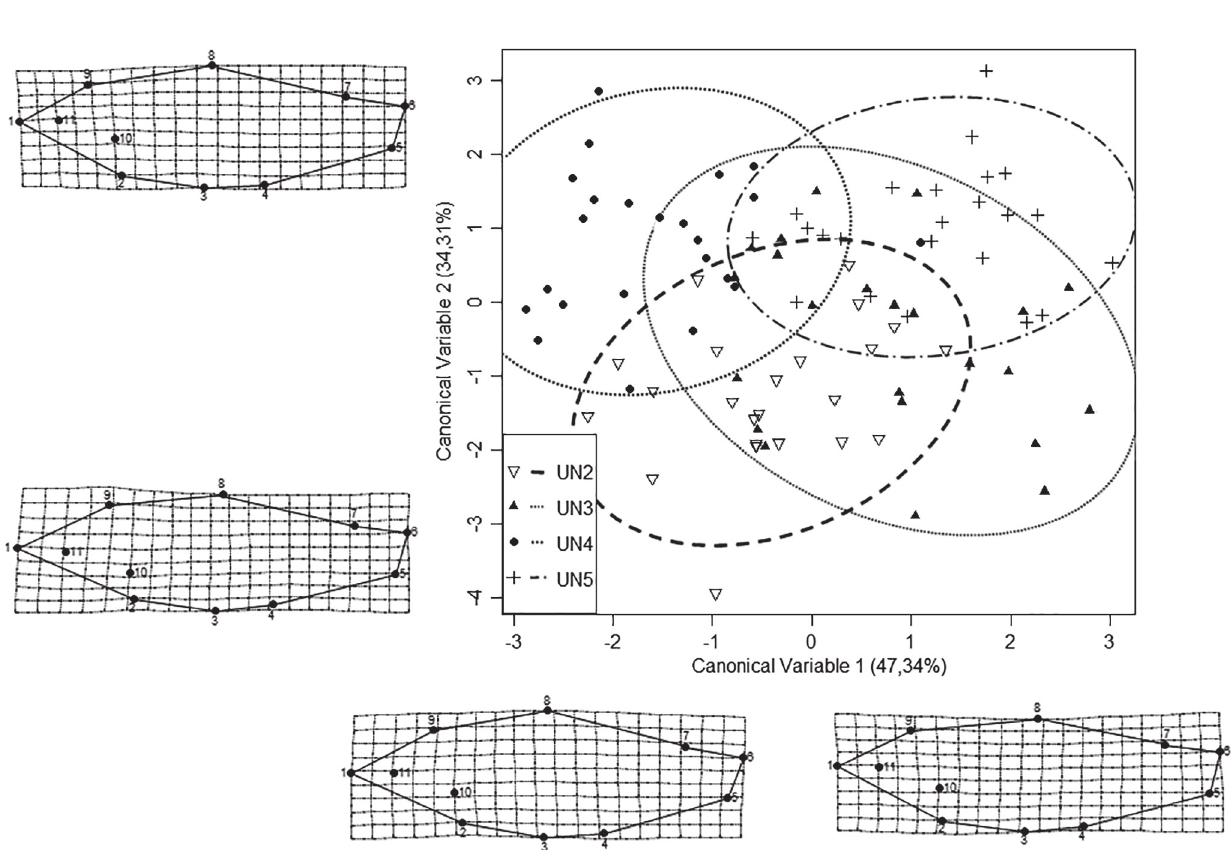
Fig. 5. Axes of morphological variation for population data set. Ellipses indicate the 95% confidence interval for each population. Deformation grids represent positive and negative extremes of the observed shape variation associated with the first and second canonical axes;